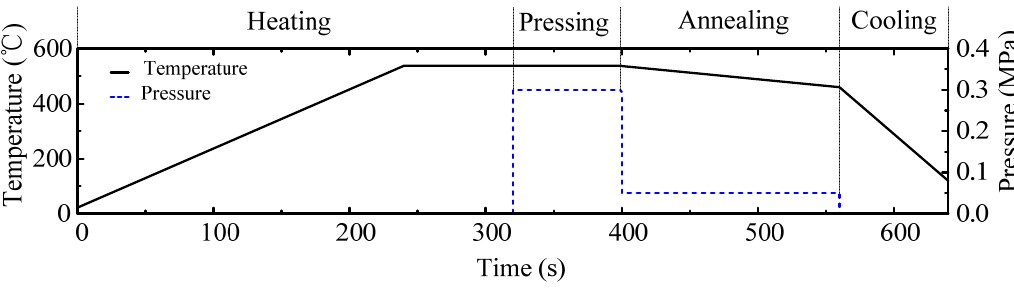
Figure 3. The typical evolution of temperature and pressure during the glass molding process (GMP).